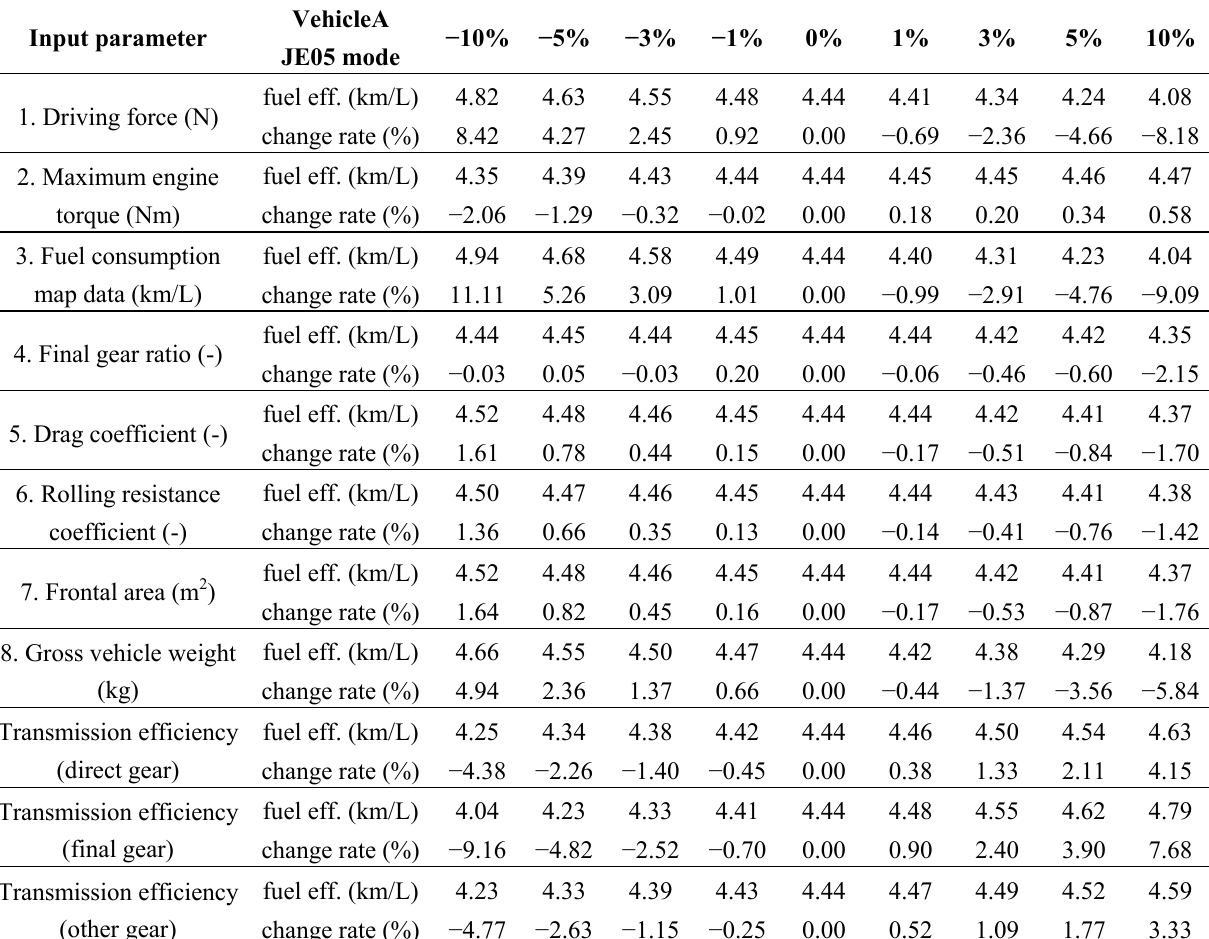
Table 9. Relative changes of the predicted fuel efficiency results compared to baseline case—case 1. Input